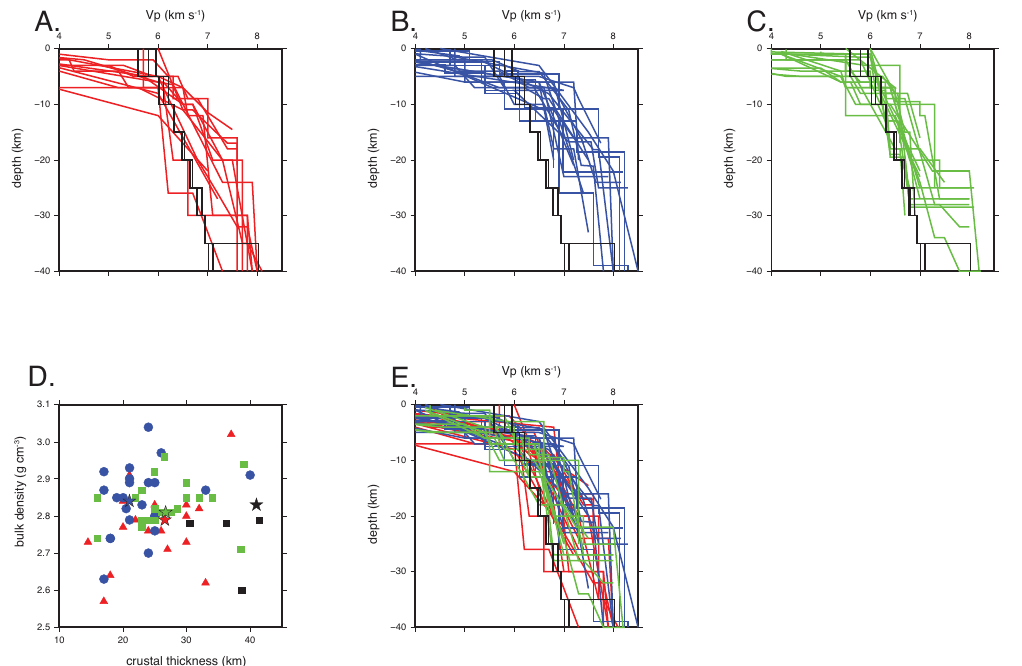
Figure 9. (a) Velocity profiles for island arcs (red), (b) oceanic LIPs (blue), (c) continental fragments (green) compared to the average velocity profiles of continental crust (black) from Christensen and Mooney (1995). (d) Bulk crustal density versus crustal thickness for oceanic plateaus (blue circles), island arcs (red triangles), continental fragments (green squares) and continental crust (black squares). Average values for FATs and continental crust are plotted as stars. All densities are converted from seismic velocities using the relationships in Christensen and Mooney (1995). (e) Velocity profiles for all FATs plotted